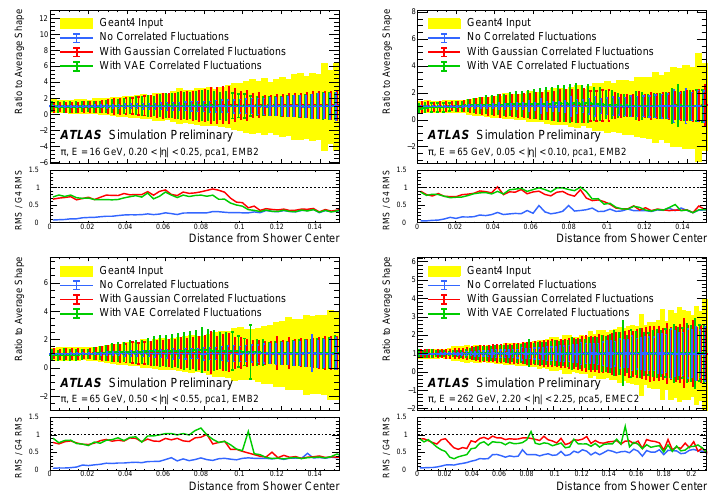
Figure 5. Comparison of the RMS fluctuations about the average shape with the Gaussian fluctuation model (red), the VAE fluctuation model (green), and without correlated fluctuations (blue) for a range of pion energies, η points, and layers